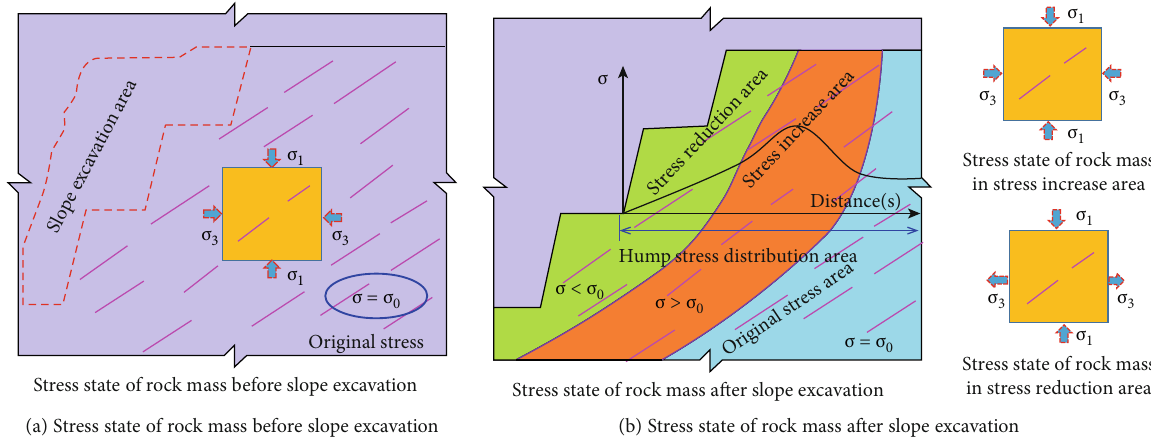
Figure 1: Stress distribution in di ff erent parts of a slope before (a) and after (b) excavation and mechanical model of the stress state of the rock mass.